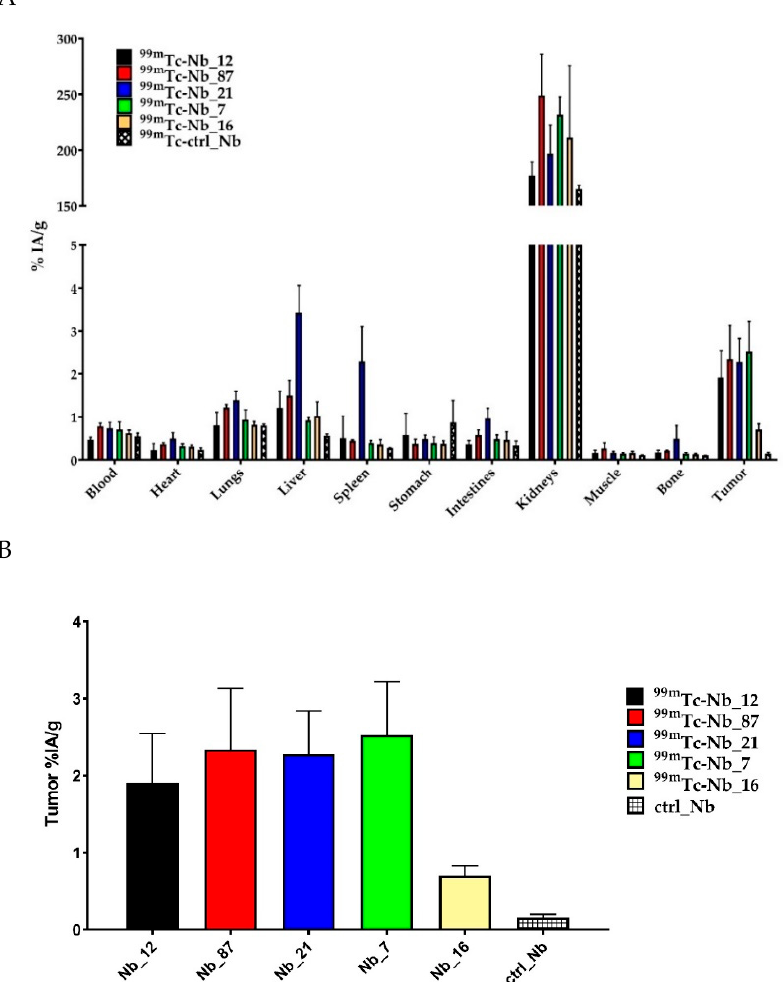
Figure 7. Graphical presentation of the biodistribution of the 99m Tc-labeled anti-CD33 Nbs and non-targeting control Nb (ctrl_Nb) in mice bearing subcutaneous THP-1 tumors ( n = 3). ( A ) Ex vivo biodistribution results obtained 1.5 h after injection. Results are presented as mean %IA/g ± standard deviation. ( B ) Mice injected with 99m Tc-labeled Nb_12, Nb_87, Nb_21, and Nb_7 showed significant higher tumor uptake compared to the group of mice injected with non-targeting 99m Tc labeled ctrl_Nb.